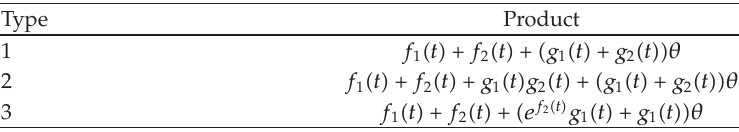
Table 1: Lie supergroup structures on R 1 | 1 .